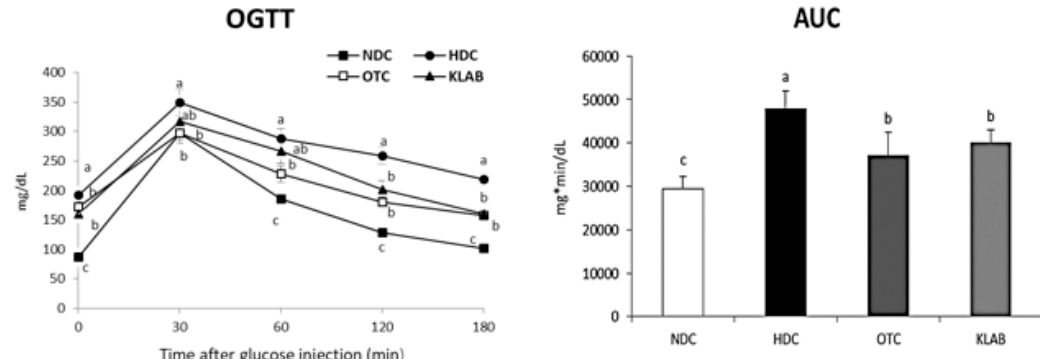
Figure 2. Oral glucose tolerance test (OGTT) and area under the curve (AUC). a-b-c; Values with different superscripts are significantly different by ANOVA with Duncan’s multiple range test at p < 0.05. NDC: Normal diet control; HDC: High fat diet control; OTC: high-fat diet plus L-ornithine 20 mg/kg; KLAB: High fat diet plus 1×10 9 CFU of L. brevis OPK-3 per mouse.